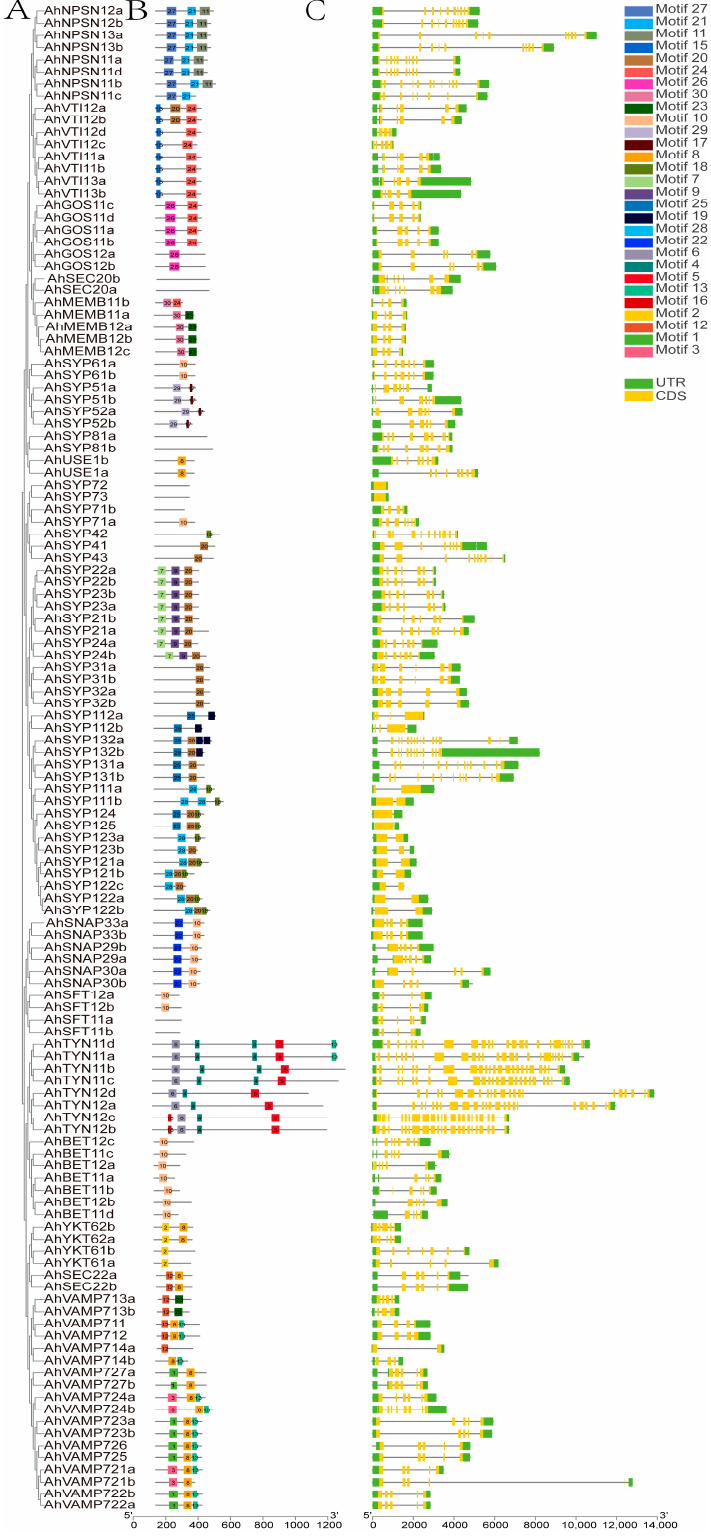
Figure 3. Phylogenetic relationships, gene structures and conserved motifs of AhSNARE genes in cultivated peanut. ( A ) Phylogenetic relationships; ( B ) conversed motifs; ( C ) exon–intron structures. Yellow boxes represent exons; gray lines represent